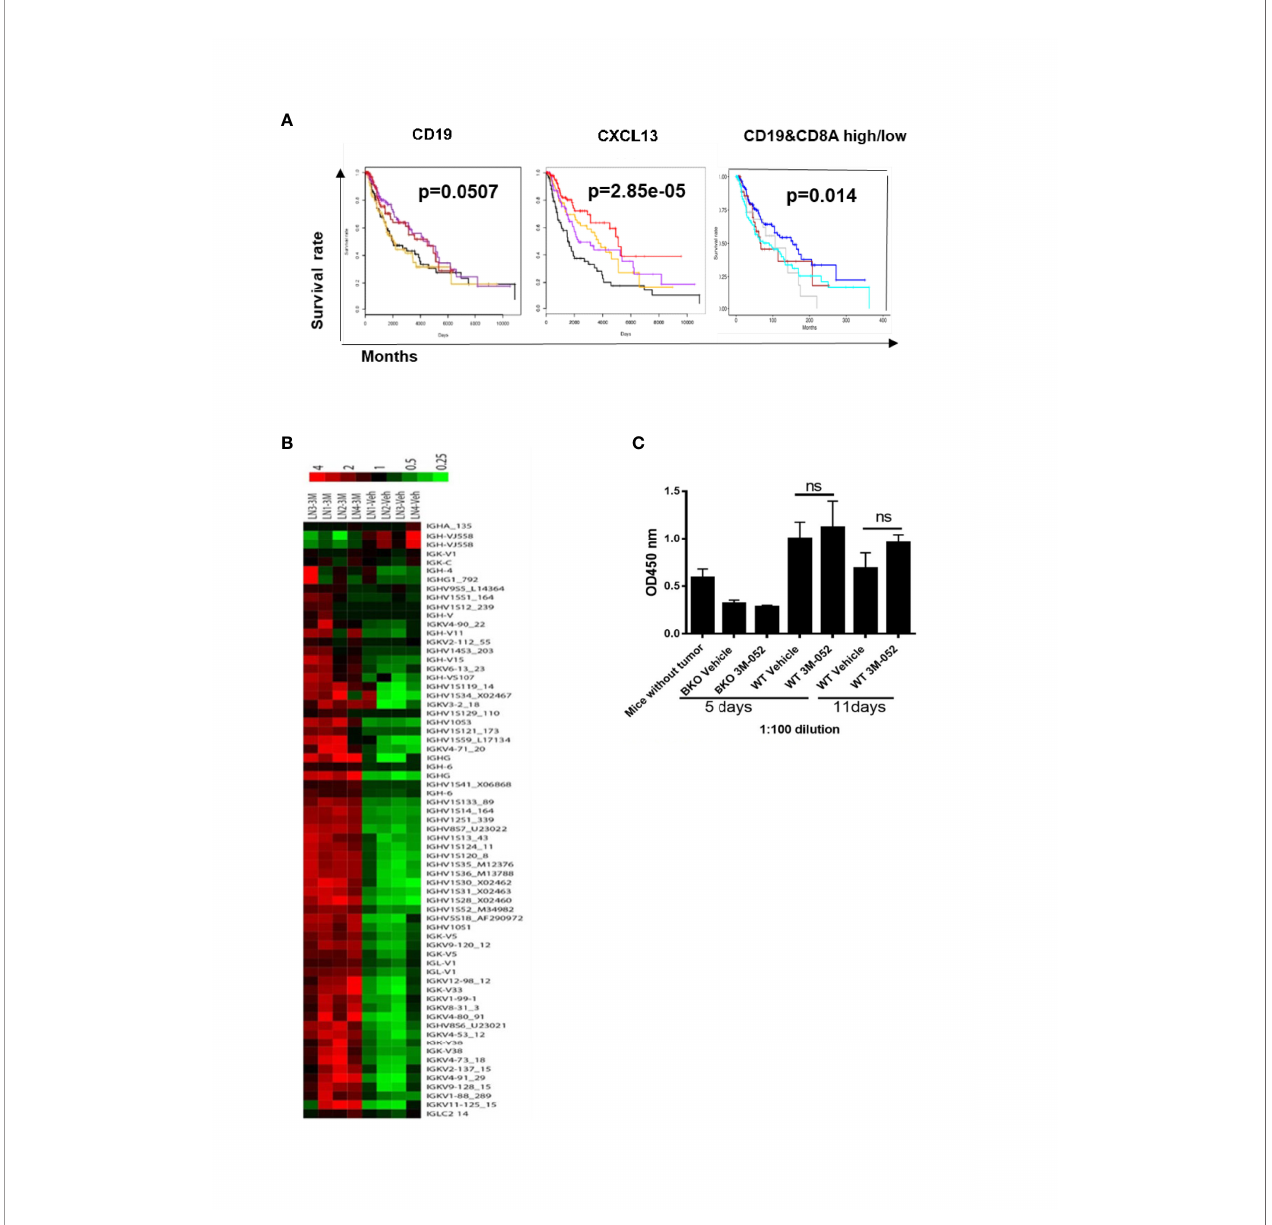
FIGURE 4 | (A) Presence of B cells (CD19+), B cell chemokine CXCL13, or B cells together with CD8+ T cells in tumors is positively associated with melanoma patients ’ survival. Kaplan-Meier plots show survival by quartiles of CXCL13 and CD19 mRNA expression (black, lowest 25%; orange, next 25%; purple, next 25%; red, highest 25%) and combinations of CD19 and CD8A mRNA expression (blue, CD19 high CD8A high; grey, CD19 high CD8A low; brown, CD19 low CD8A high; cyan, CD19 low CD8A low). High expression was de fi ned as above, and low expression was de fi ned as below the median gene expression. The P-values were derived from log-rank tests. (B) Microarray of tumor-draining lymph nodes after 4 days of treatment with TLR-7/8 agonist (3M or 3M-052) or vehicle (Veh). Shown are genes of the variable or constant region of Ig heavy or light chain (4 mice/group). (C) B16-speci fi c IgG antibodies in serum in response to treatment with TLR-7/8 agonist (3M-052) or vehicle; unpaired Student ’ s t-test (5 mice/group). NS, not signi fi